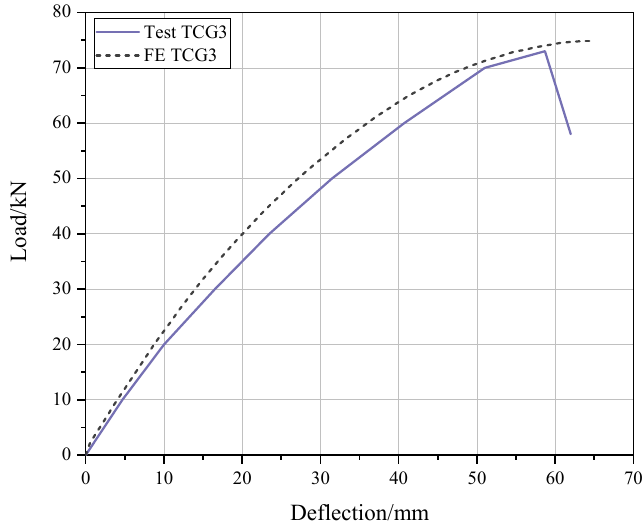
Figure 16. Comparison of experimental and finite element results of the load–deflection curves.